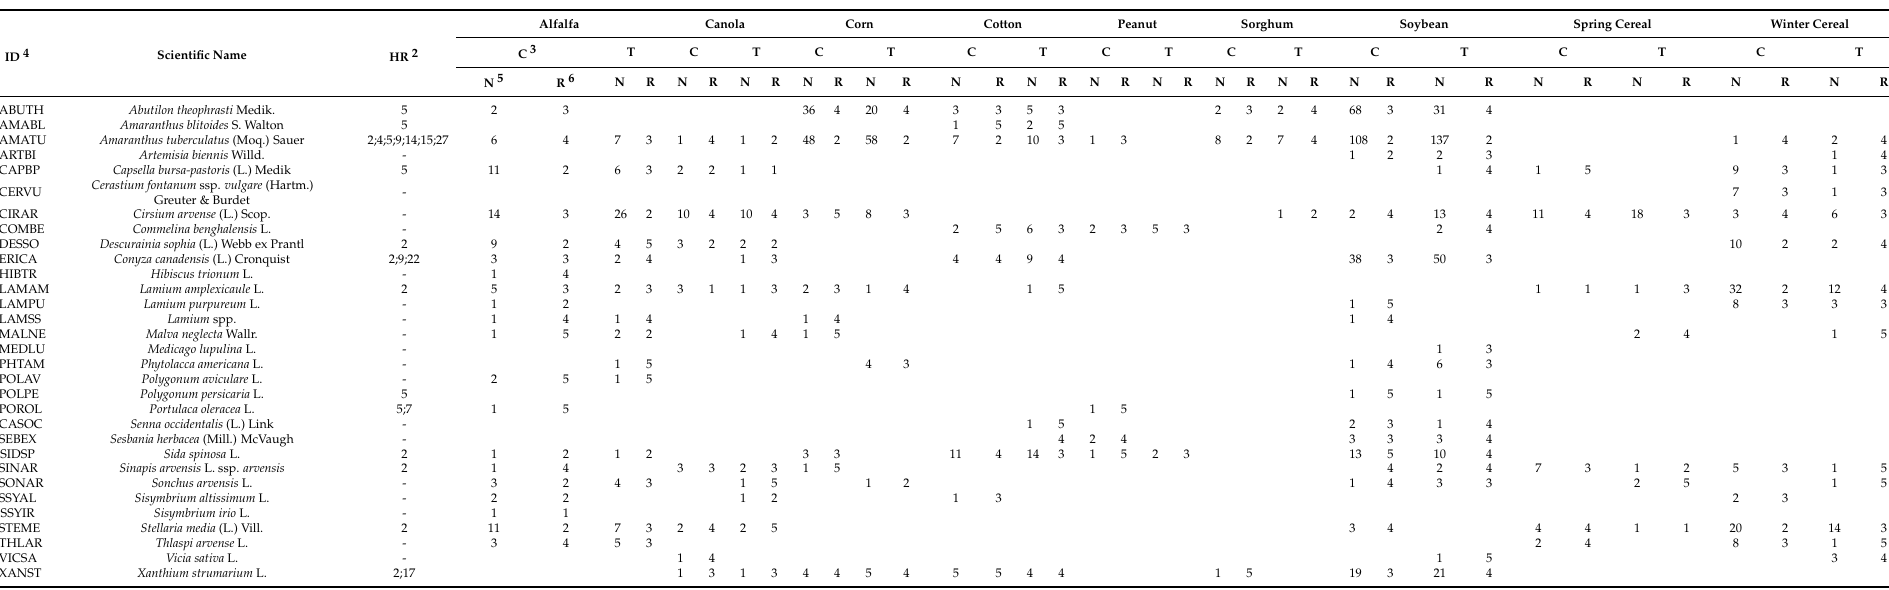
Table 2. Weeds known to host SCN that are also found on the “Most Common” and “Most Troublesome” weed lists 1 for soybean and rotational